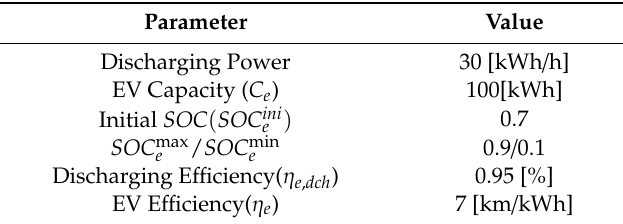
Table 2. Electric vehicle (EV) parameters for V2G scheduling.